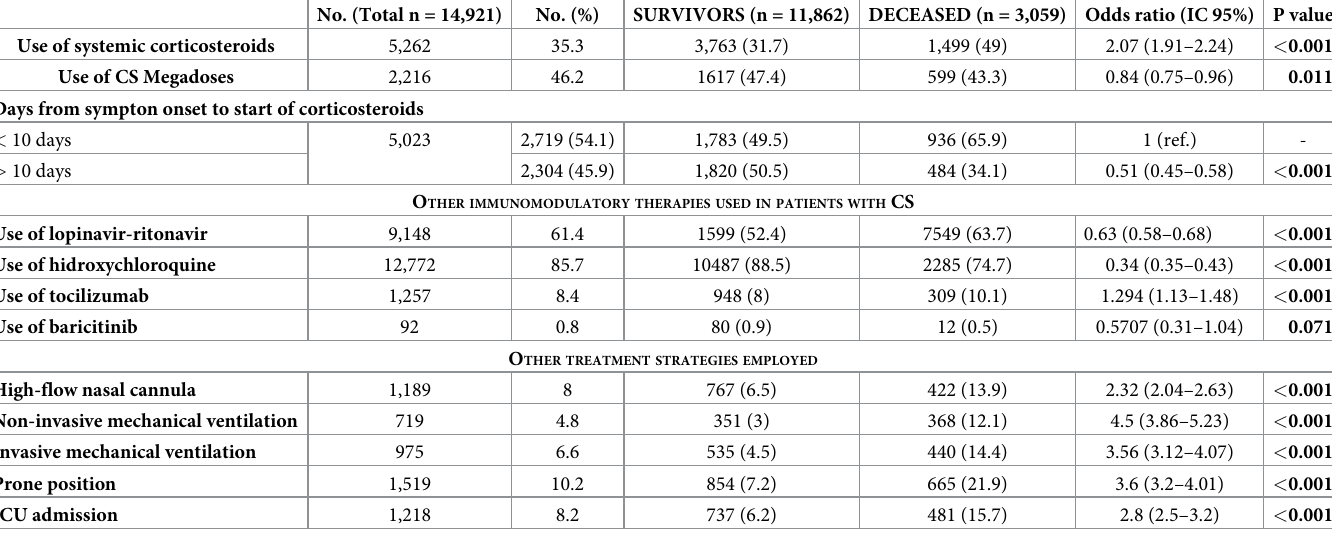
Table 6. Corticosteroids therapy and mortality.